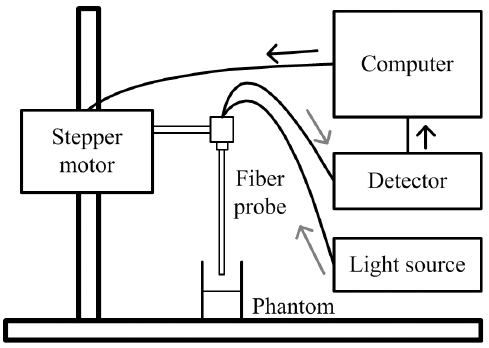
Fig. 3. The schematic representation of measurement